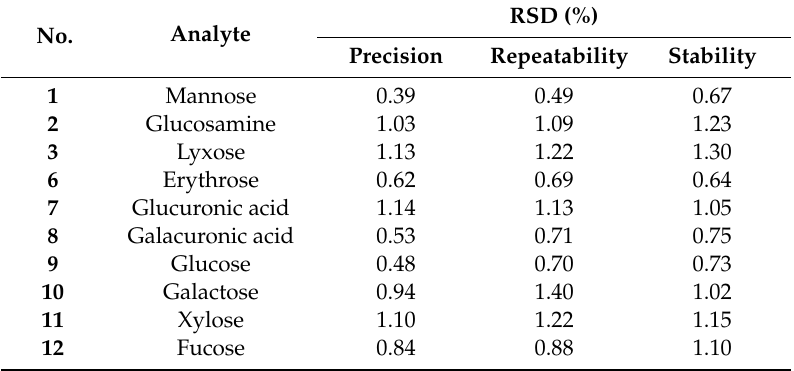
Table 3. Precision, repeatability and stability of 10 monosaccharide derivatives. RSD: relative standard